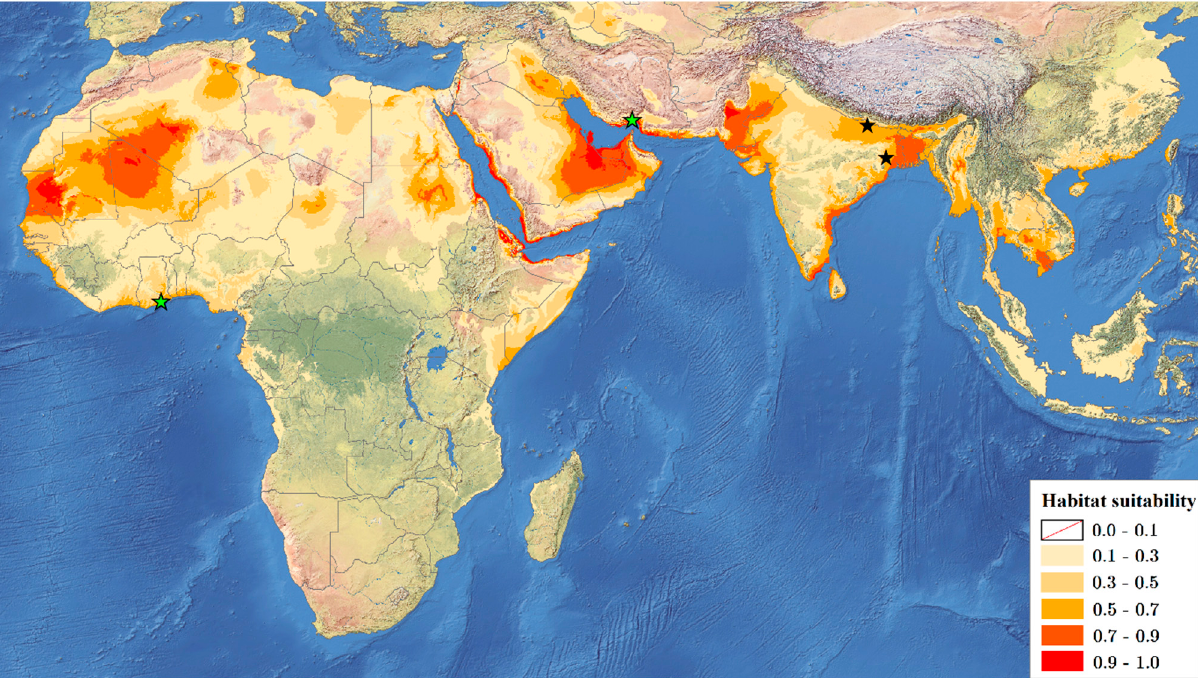
Figure 2. Maxent ecological niche modelling results for Recaredus rex . Red and dark orange colours mark areas with high habitat suitability for the species. Literature sites (India) are marked with black stars, while new locations (Iran, Ghana) are marked with green stars.